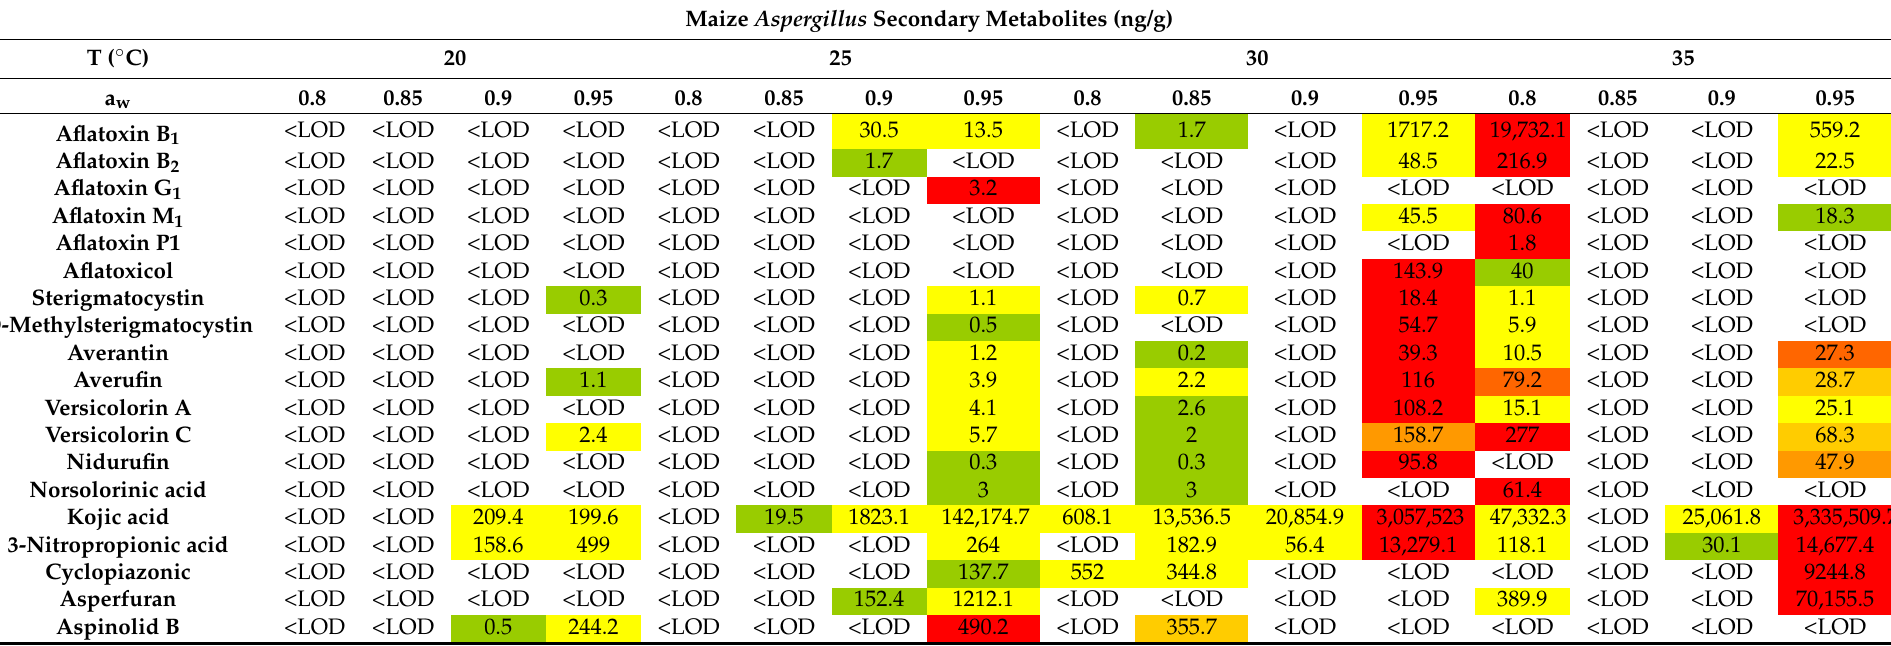
Table 2. Summary of the major secondary metabolites (ng/g) of Aspergillus species present in the maize under different temperature × water activity conditions. The conditions highlighted in green (low concentrations), yellow (medium concentrations) and red (highest concentrations) were found. LoD: Limit of Detection.